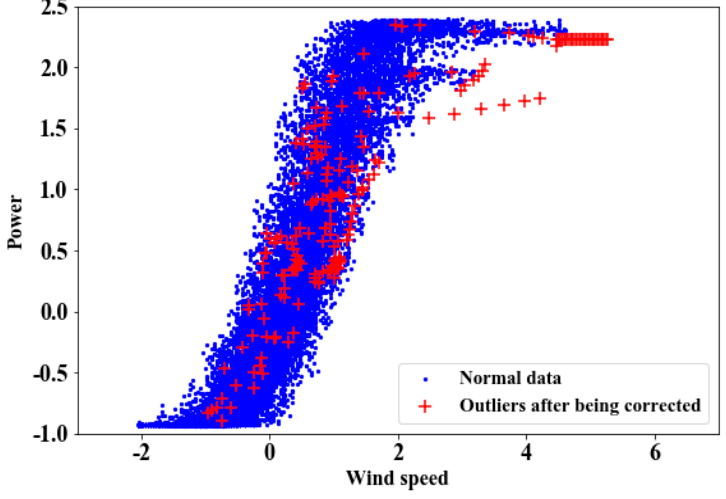
Figure 4. The correction effect of outliers.